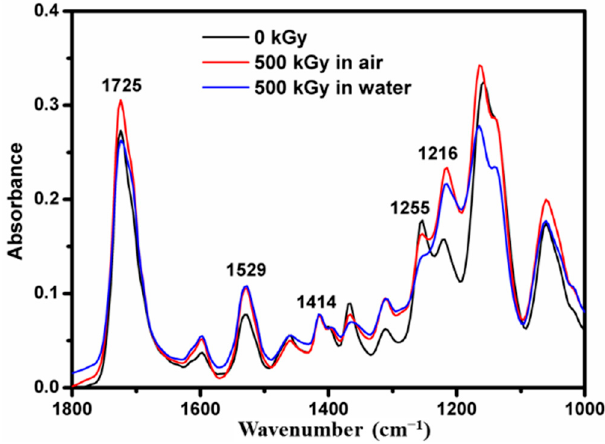
Figure 5. FTIR spectra of the Estane samples irradiated at the dose of 500 kGy in air and water.